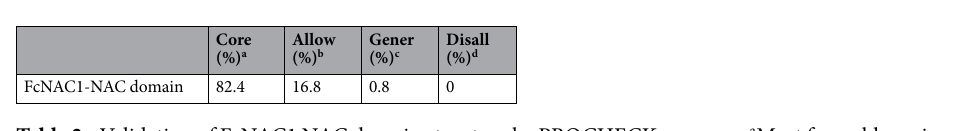
Table 2. Validation of FcNAC1 NAC domain structure by PROCHECK program. a Most favorable regions. b Additional allowed regions. c Generously allowed regions. d Disallowed